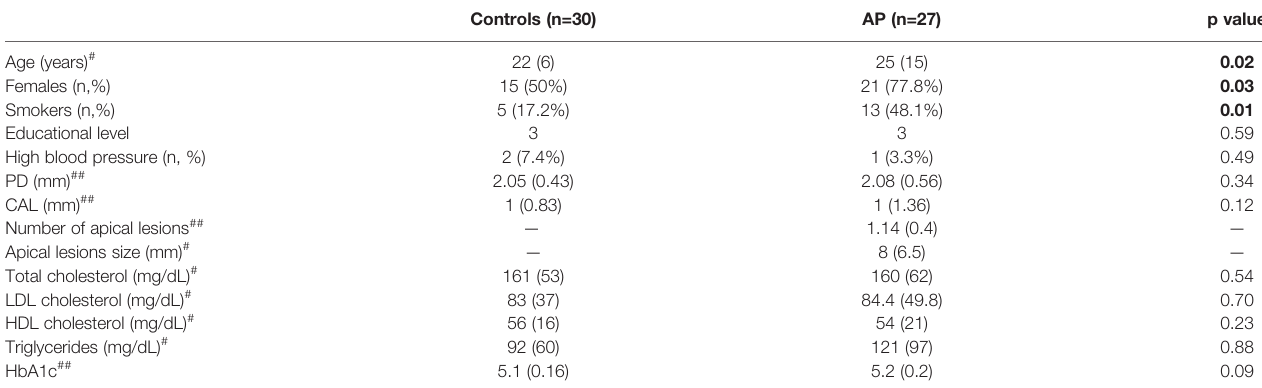
TABLE 1 | Sociodemographic, general, oral, and serum parameters of study individuals with apical periodontitis (AP) and healthy controls. Controls (n=30)